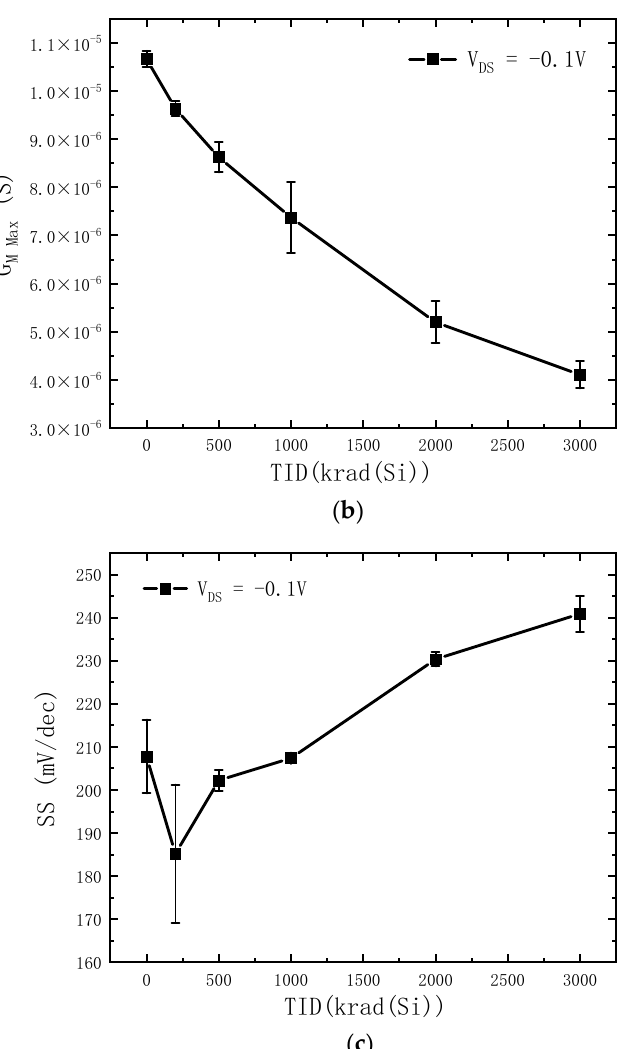
Figure 3. The changes of ( a ) threshold voltage ( V th ), ( b ) maximum transconductance ( G M Max ) and ( c ) subthreshold swing (SS) after